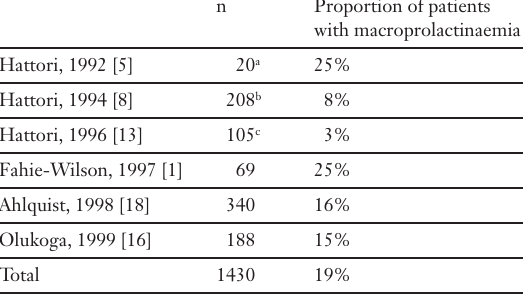
Figure 2 Results of PEG precipitation test in 17 patients with macroprolac- tinaemia ( ✦ ) as a function of the chromatographi- cally quantified macroprolactin con- tent. The control sera without macro- prolactin ( ❍ ) all show a prolactin re- covery after PEG of over 40%. The over- lap encompasses one single sample containing little amounts of macro- prolactin (8% as de- tected by gas filtration chromatog- by kind permission of the